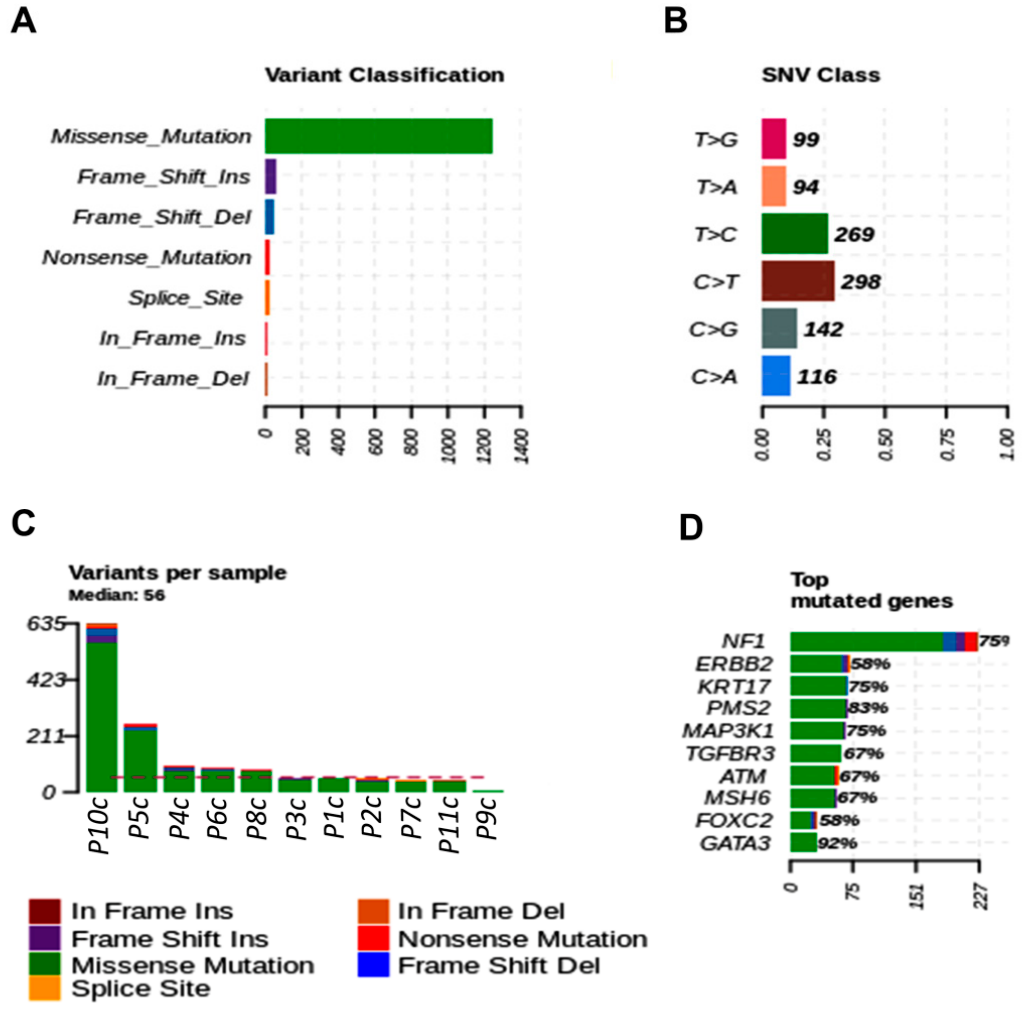
Figure 5. Genetic variation in plasma samples of dogs with BC. ( A ) Representative variant classification. ( B ) Single- nucleotide variant (SNV) classification. ( C ) Representative variants per plasma sample. ( D ) Top mutated genes showing multiple variant mutations. Graphics were generated in the R language, using the Maftools package.